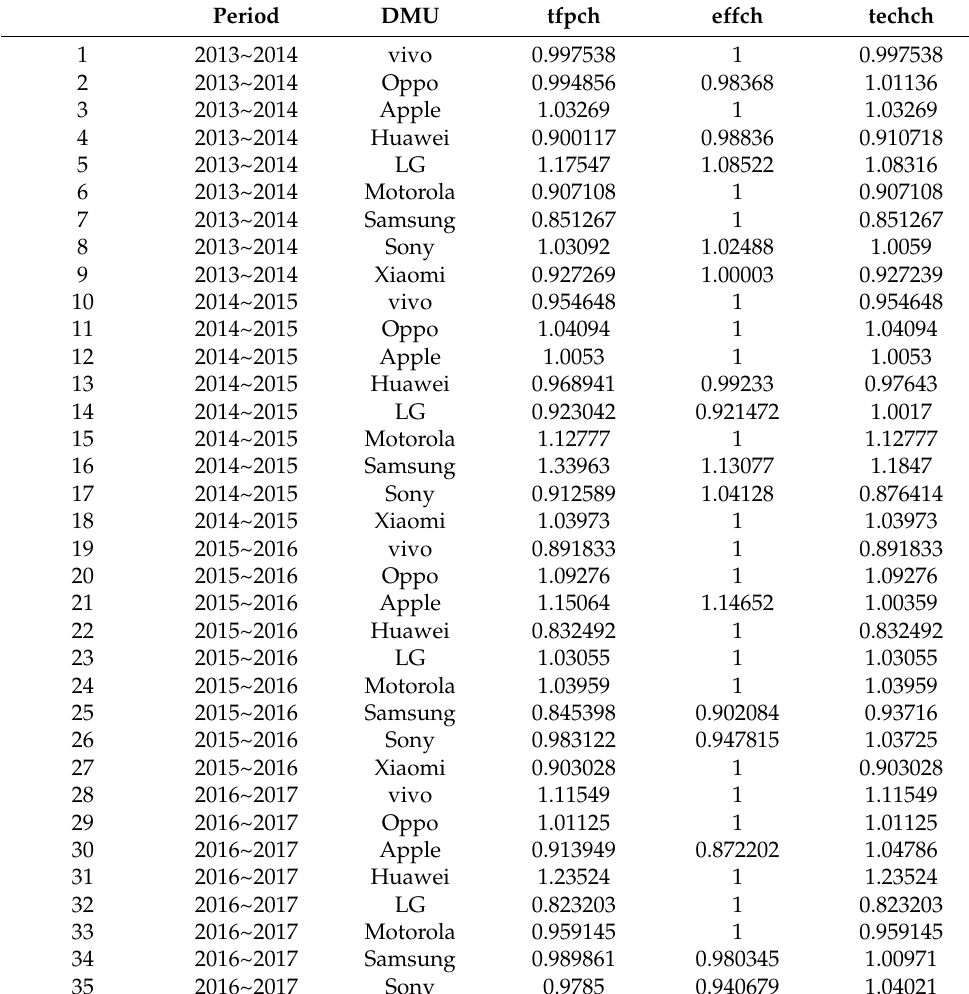
Table 4. Results of Malmquist Productivity Analysis. Period DMU tfpch